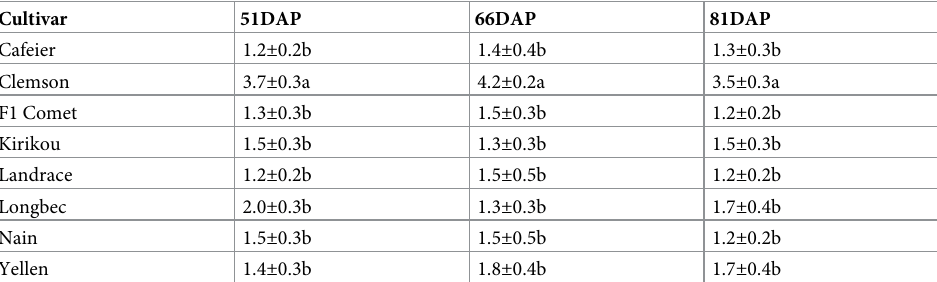
Yellen 1.4 ± 0.3b 1.8 ± 0.4b 1.7 ± 0.4b Values with the same letter in a column are not significantly different from each other under Tukey test at a 5% probability